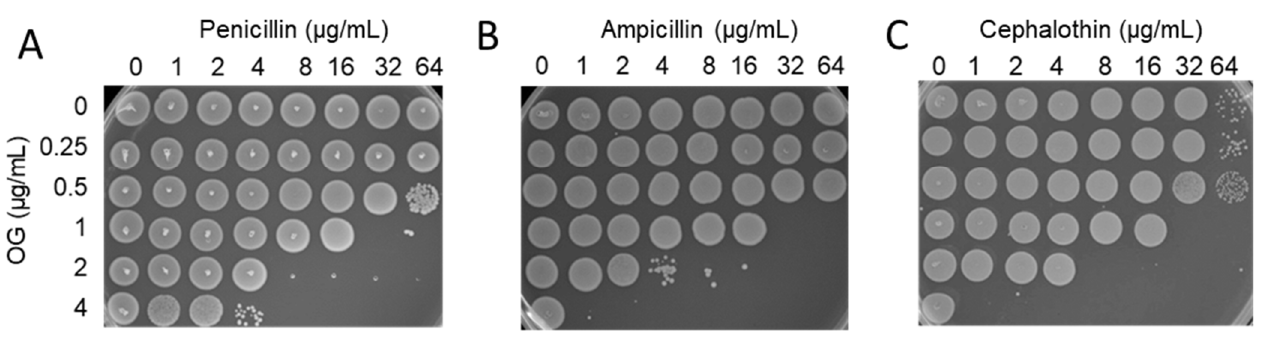
Table 2. MIC and FIC index of octyl gallate (OG) and β -lactam combinations against MRSA isolates from clinical cases in humans.